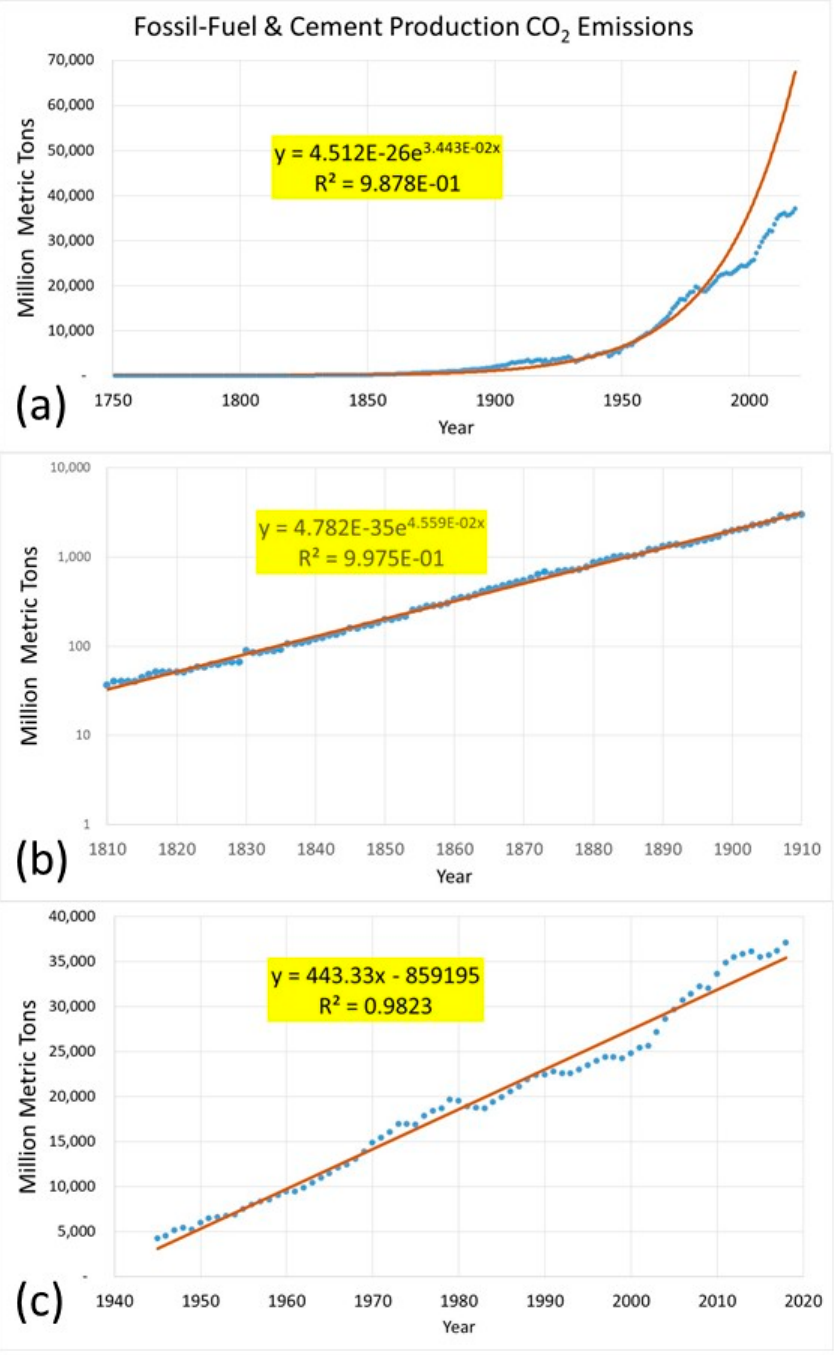
Figure 5. ( a ) Comparison of best fit exponential growth curve with fossil fuel and cement production CO 2 emissions (1750–2018). ( b ) Comparison of best fit exponential growth curve with fossil fuel and cement production CO 2 emissions (1810–1910). ( c ) Comparison of best fit linear growth curve with fossil fuel and cement production CO 2 emissions (1945–2018).